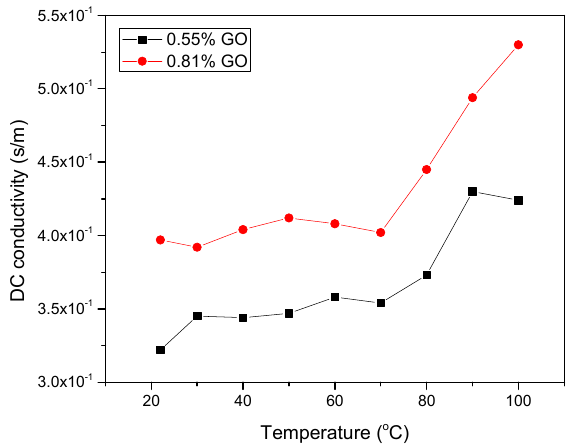
Figure 14. Direct current (DC) conductivity as a function of temperature of P(VDF-CTFE)/GO.